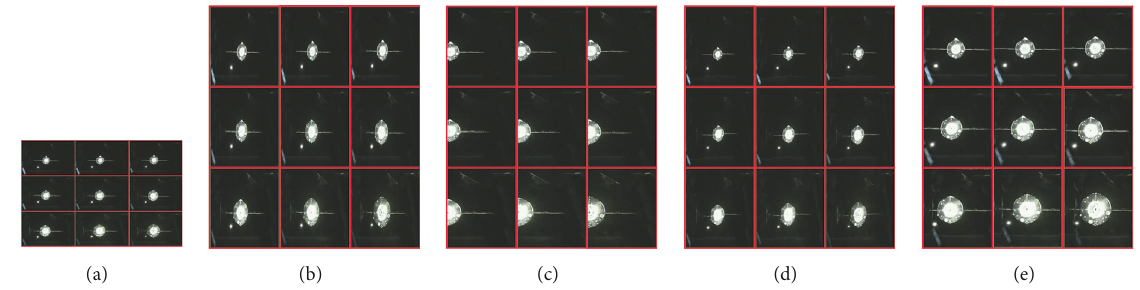
Figure 11: Comparison results of sequence S8 using four methods when the resolution is resized from 576×432 to 600×800 . (a) The original frames, (b) scaling, (c) the best cropping, (d) ISC, and (e) PTDS.